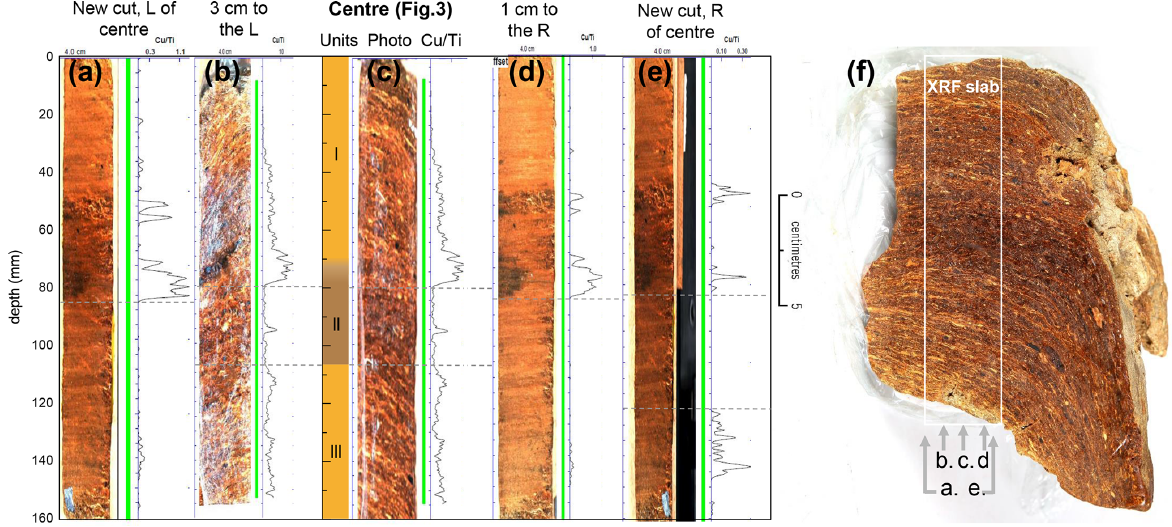
Figure A1. Consistency of XRF scanning signals in deposit WMM7. The XRF data presented in Fig. 3 were recovered from a central slab of WMM7, where we identified the longest sequence of horizontal laminae (Fig. 3). Here we show additional scans to investigate the internal consistency of the signals. Panels (a) – (e) correspond to lines a–e in panel (f) . Scans were undertaken to the left (b) and right (d) of the centreline (c) , and then two further cuts were used to investigate signals perpendicular to the cut surface (a, e) . Away from the central line the signals are less strong and sometimes intermittent, but the laminae also dip sharply away from the centre (f) , suggesting more heterogenous accumulation, perhaps due to distance from the nest and/or nest morphology.